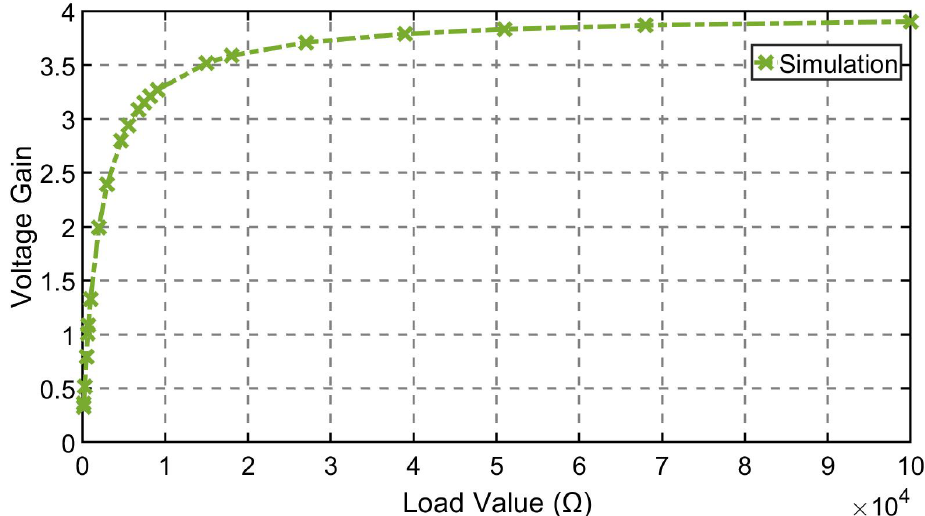
Figure 8. Simulated voltage gains at different load